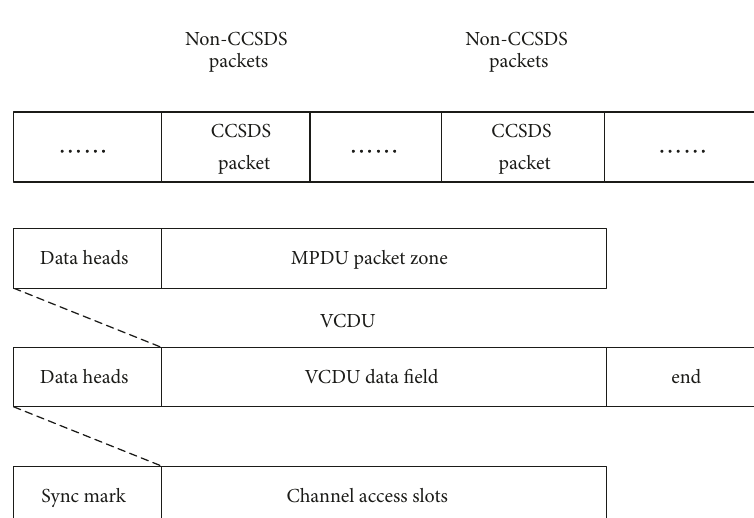
Figure 1: The AOS multiplexing process.